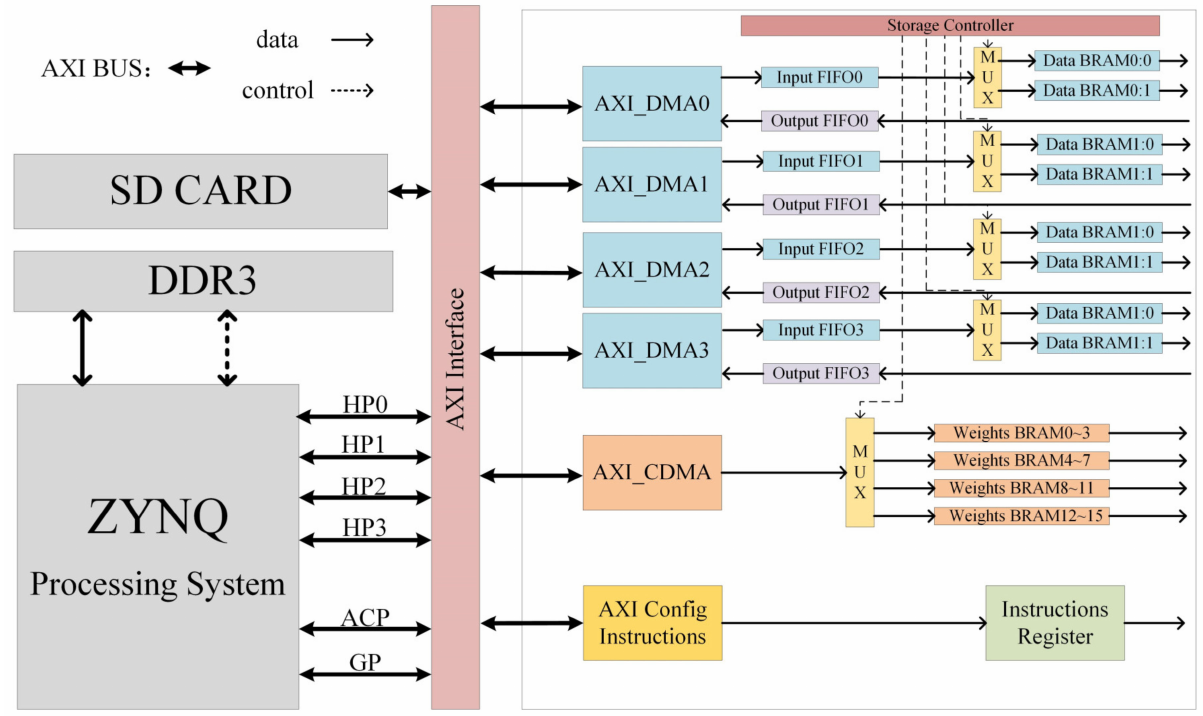
Figure 3. Data transfer